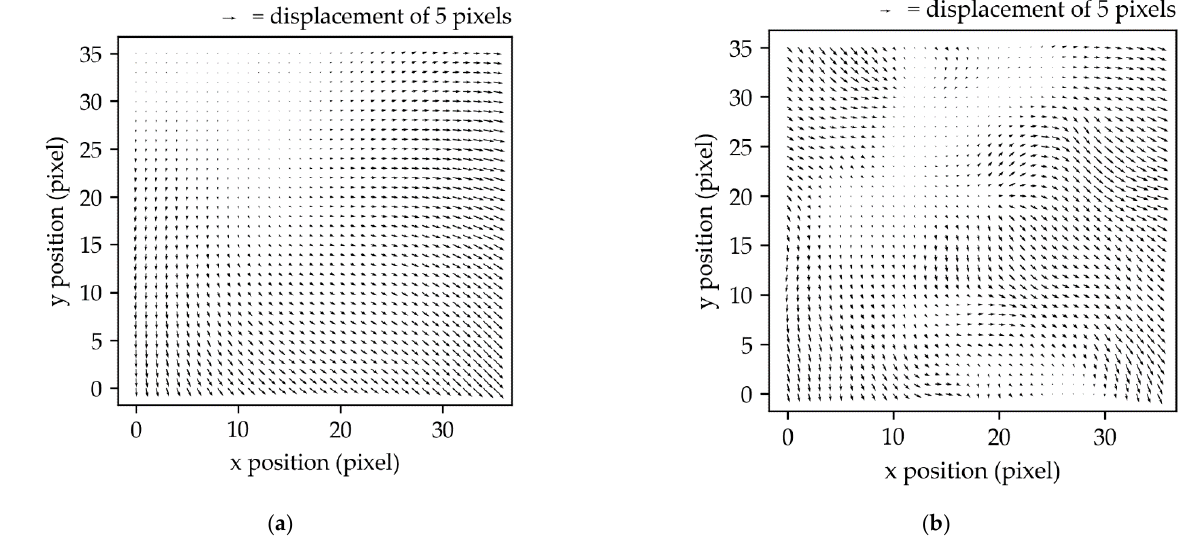
Figure 10. Example of slave image deformation fields for the B-SPLINE method with a final grid spacing of ( a ) 16 pixels; ( b ) 2 pixels. The deformation fields were extracted for a 36 × 36 pixels image region. The lengths of the arrows are proportional to the pixel displacement.